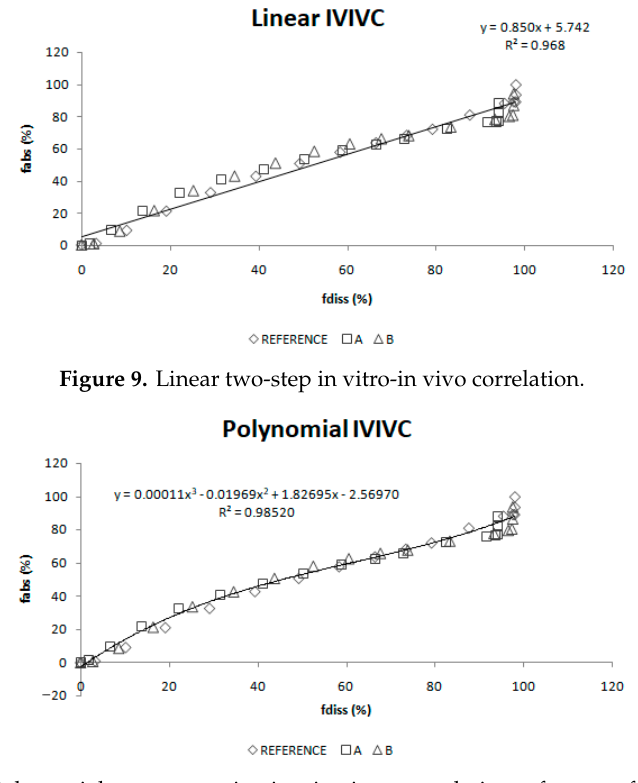
Figure 10. Polynomial two-step in vitro-in vivo correlation. f abs = fraction absorbed, f diss = fraction dissolved.